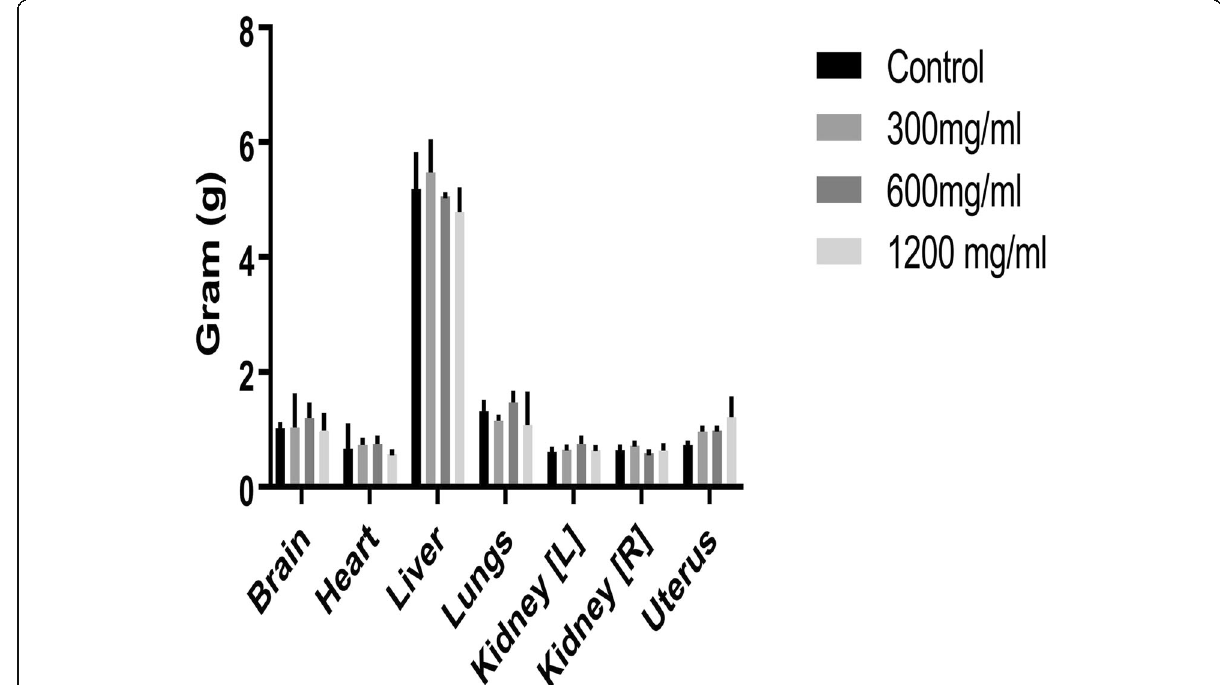
Fig. 4 Effect of STRE on organ weight of female subjects. Values are expressed as mean±SEM Statistical significance (p) calculated by one way ANOVA followed by dunnett ’ s ( n